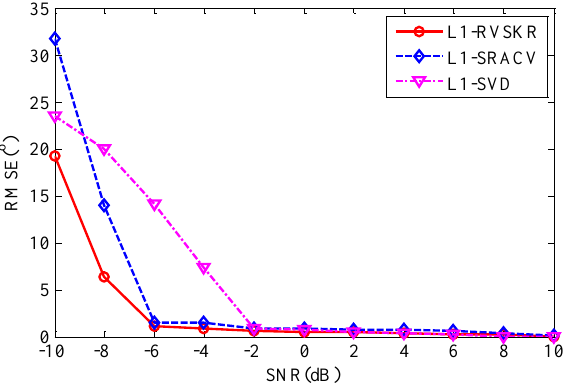
Figure 3. Root mean square error (RMSE) of DOA estimation versus SNR.